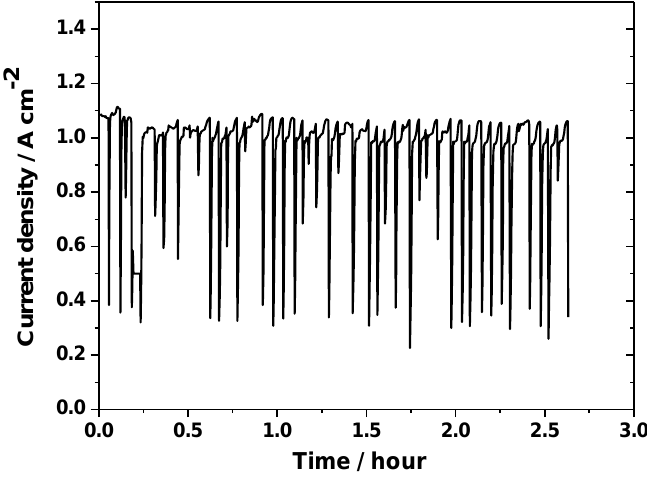
Figure 3. A typical water flooding pattern in a PEM fuel cell operated at constant cell voltage (0.6